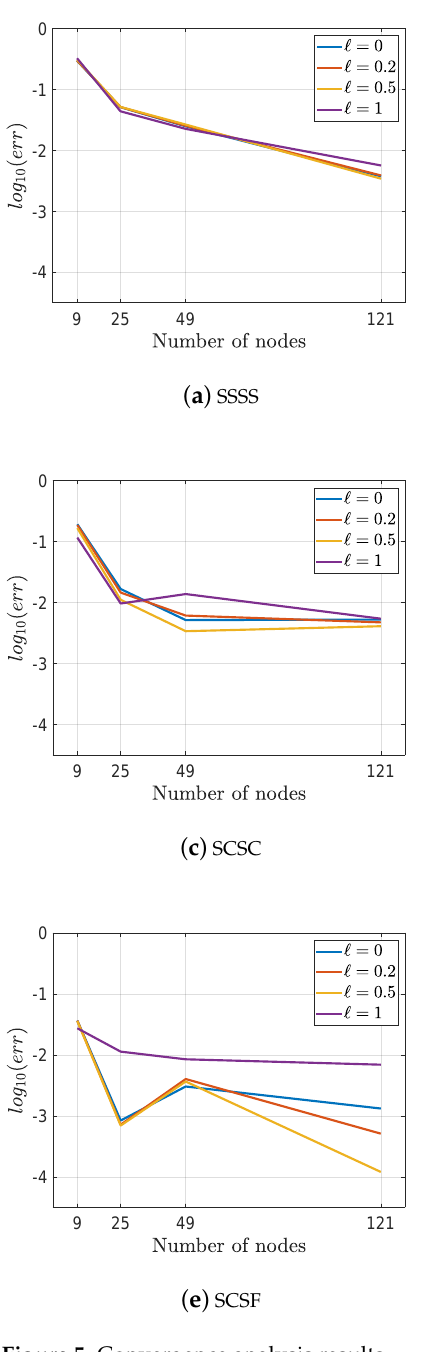
Figure 5. Convergence analysis